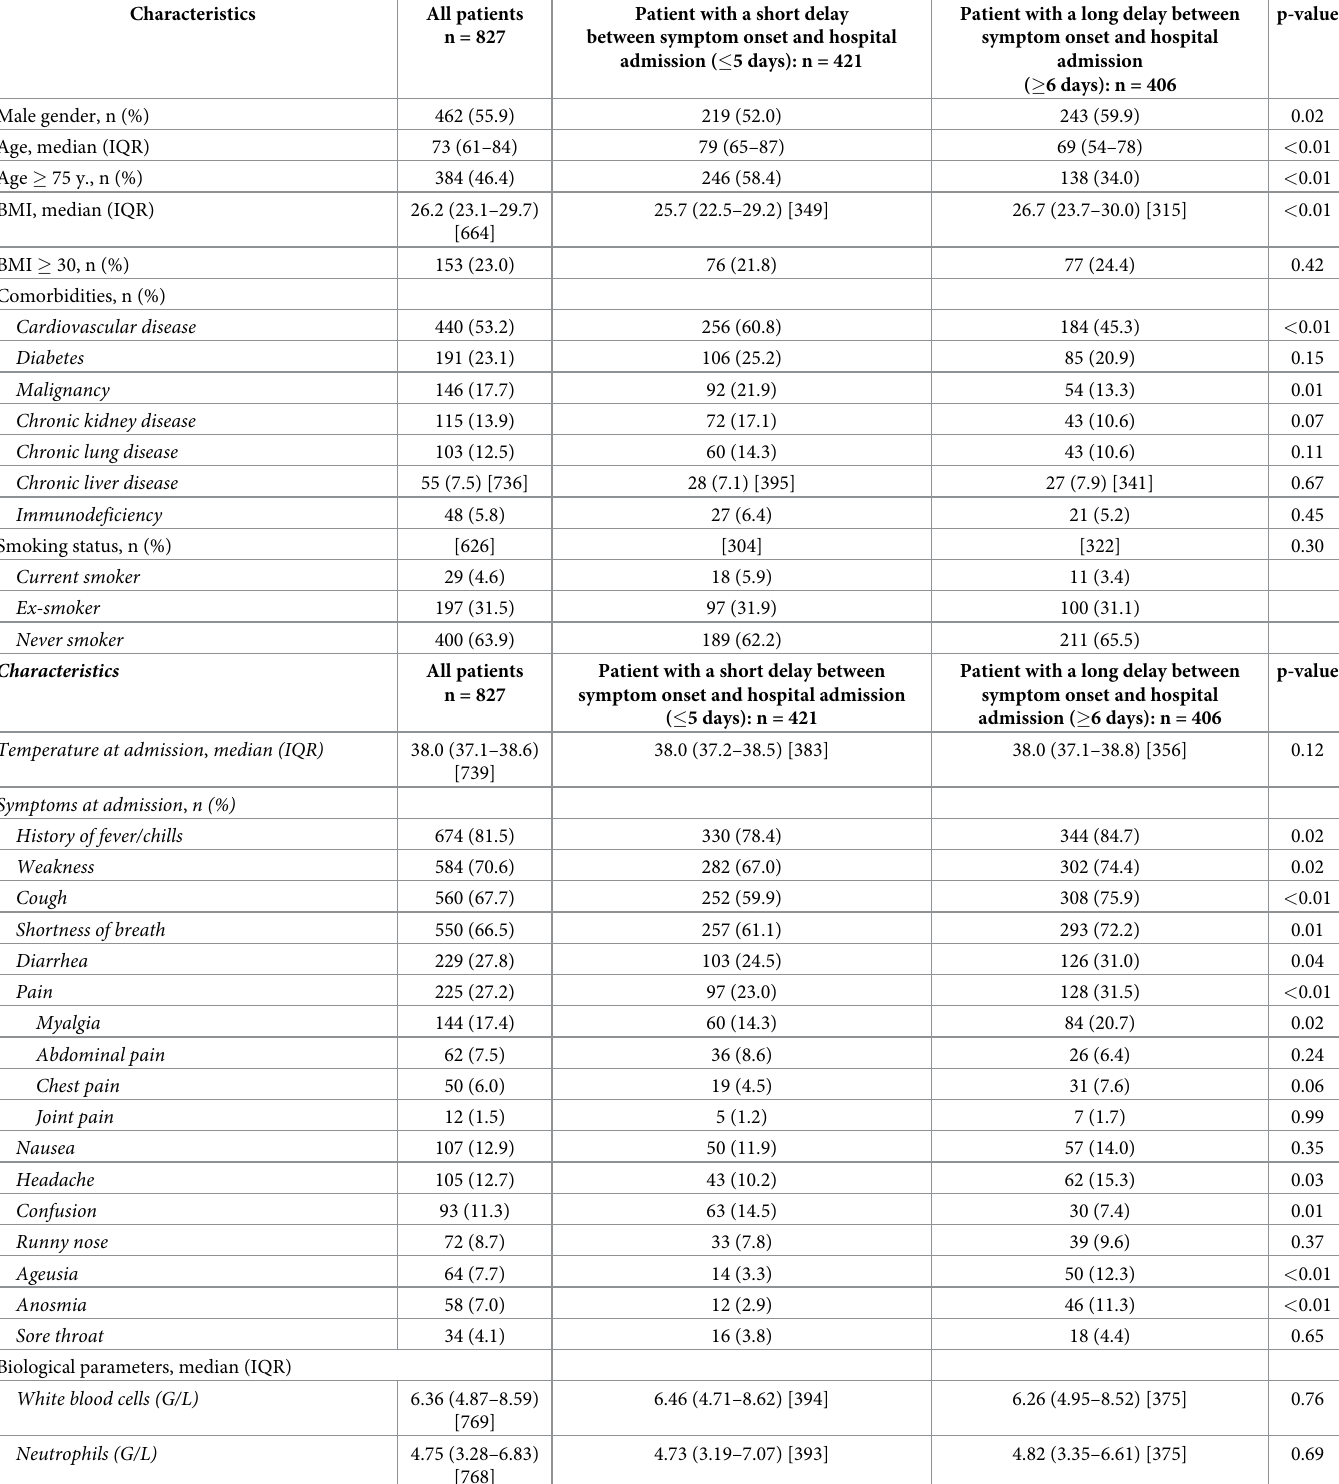
Table 1. Characteristics of the study population according to delay between symptom onset and hospital admission, Lyon University Hospital (NOSO-COR Study), February 8–June 30,